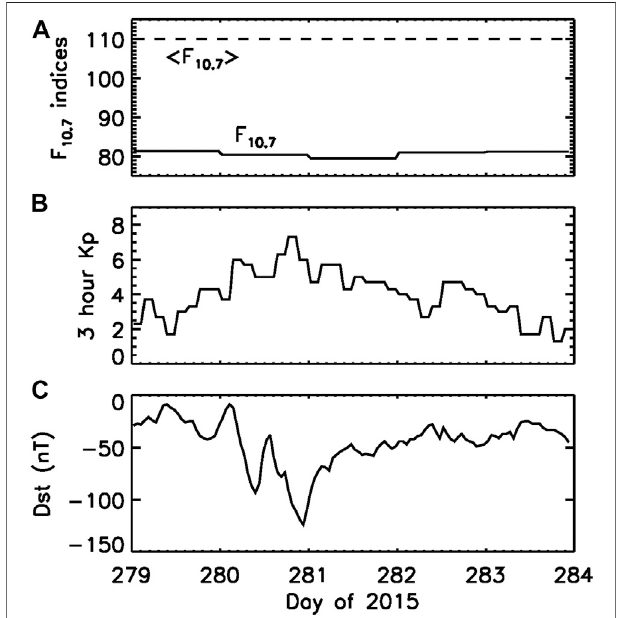
FIGURE1| Simulation inputs (A) F 10.7 EUVindexand F 10.7 A ,its81-days average value, (B) decimal Kp index, and (C) Dst index. During the model storm, magnetospheric convection is driven by Kp and ring-current heating of electrons is driven by